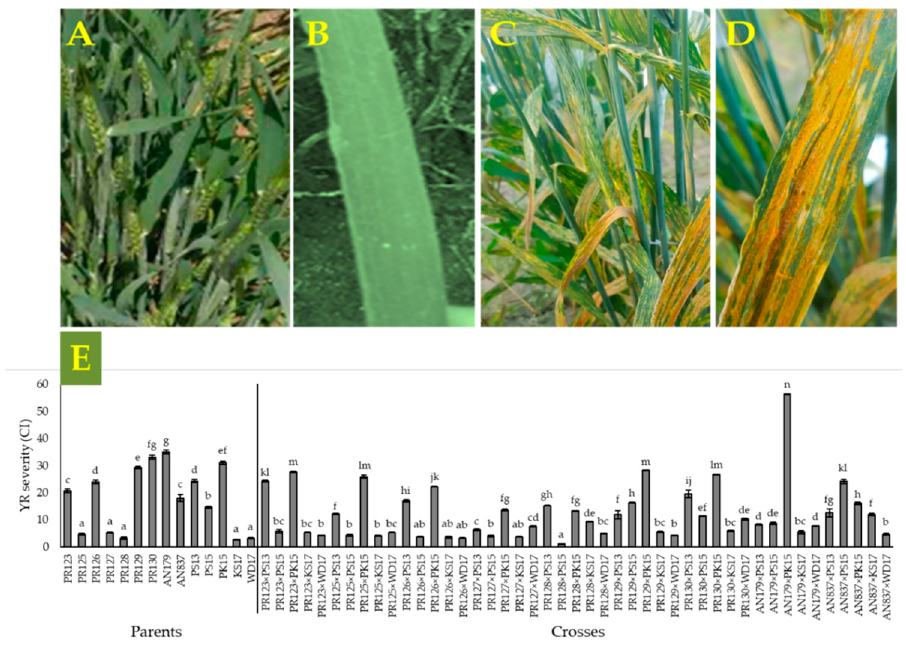
Figure 1. Field appearance and infection data of yellow rust disease severity of wheat plants. Panels ( A , B ) show plants under optimal with no YR symptoms. Panels ( C , D ) show plants under YR-stress with severe YR symptoms. Panels ( A , C ) show whole plant view at reproductive stage, whereas ( B , D ) show close-up view of individual leaves (Photo credit: M. Saeed). ( E ) Mean YR severity in parents and crosses. Bars represent coefficient of infection (CI), error bars represent standard error, and different alphabets on bars depict pair-wise significant variations ( p < 0.05). Table 3. Analysis of variance for physiological, yield and yield components, bio-chemicals traits under optimal and YR-stress conditions.